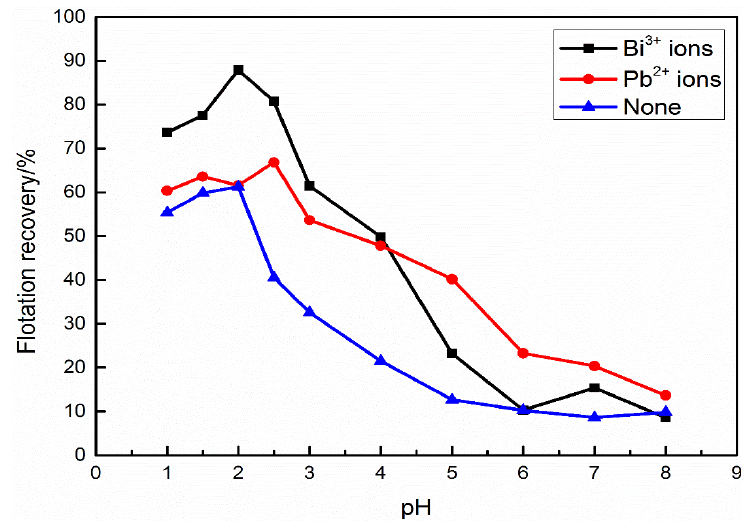
Figure 3. The flotation recovery of rutile as a function of pH in the presence of 600 mg/L styryl phosphoric acid (SPA): [Bi 3+ ] = 10 −5 mol/L; [Pb 2+ ] = 10 −4 mol/L.